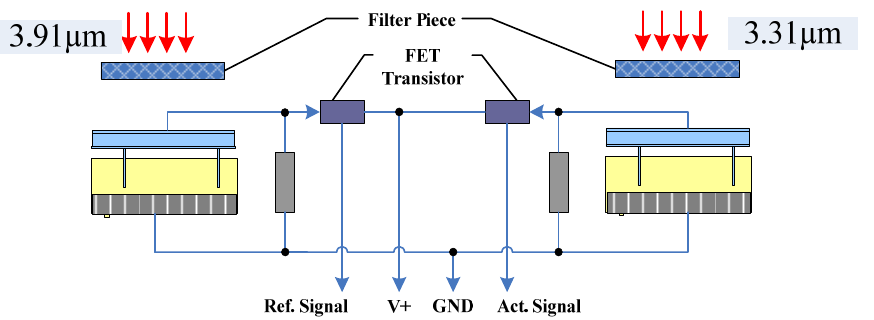
Figure 4. Schematic diagram of IR gas